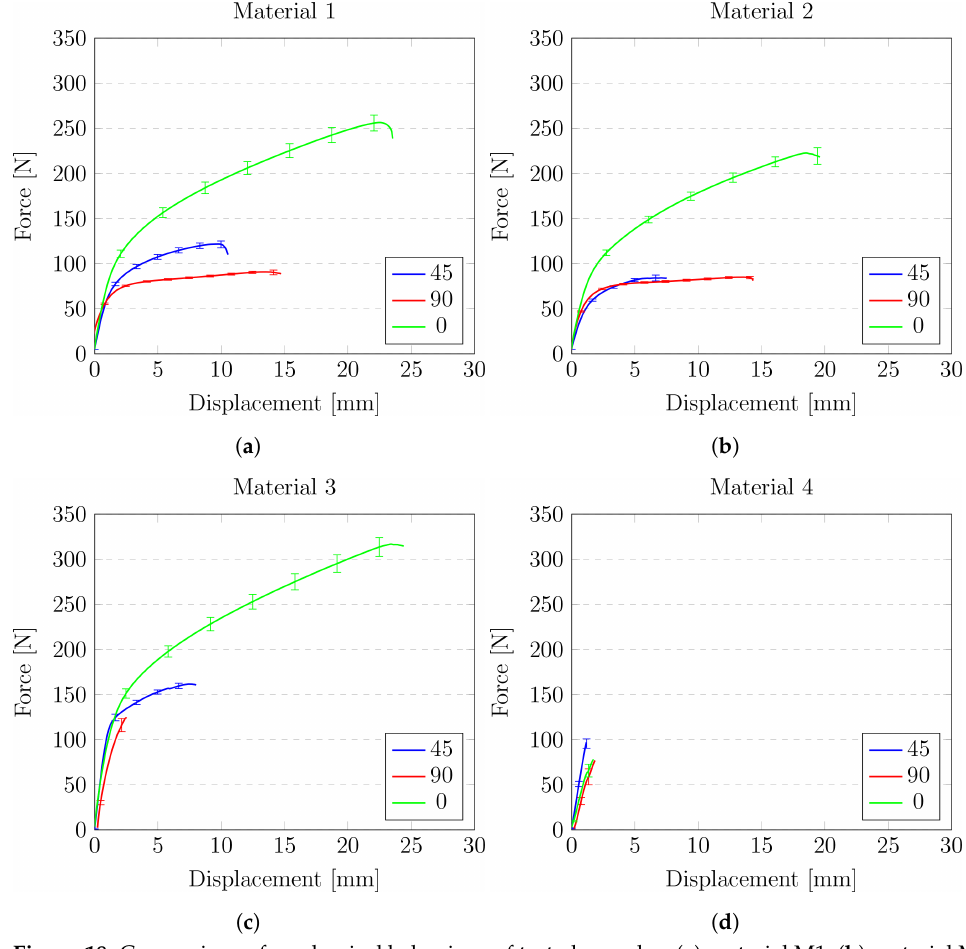
Figure 18. Comparison of mechanical behaviour of tested samples: ( a ) material M1; ( b ) material M2; ( c ) material M3; ( d ) material